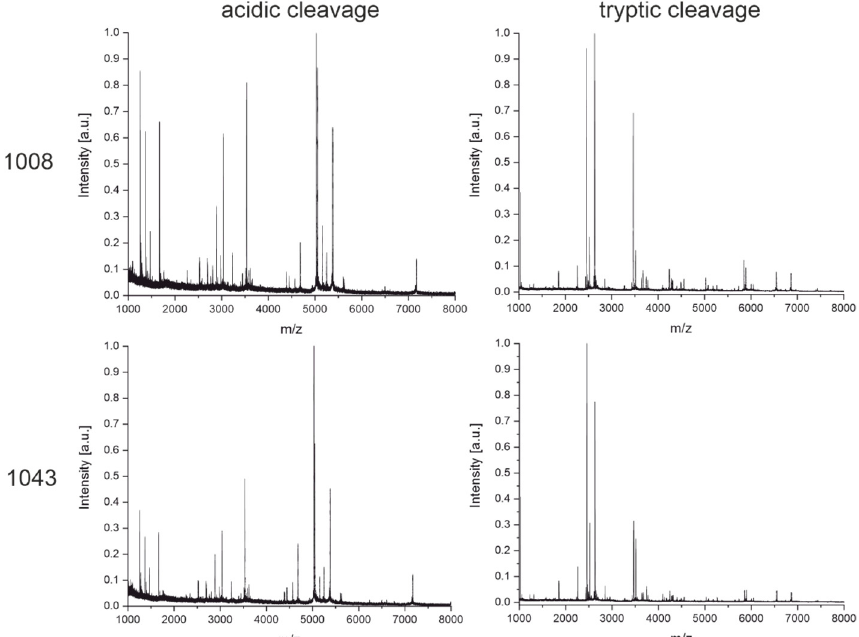
Figure 9. MALDI-TOF fingerprint spectra of the monoclonal antibodies 1016 and 3405 were ob- tained from cleavage with diluted sulfuric acid for 30 min at 99 °C and tryptic digestion for 15 min at 55 °C. Antibodies 1016 and 3405 originated from different immunizations but have similar light chain and intact masses. However, some obvious differences showed up in the fingerprints based on acidic cleavage and tryptic digest.